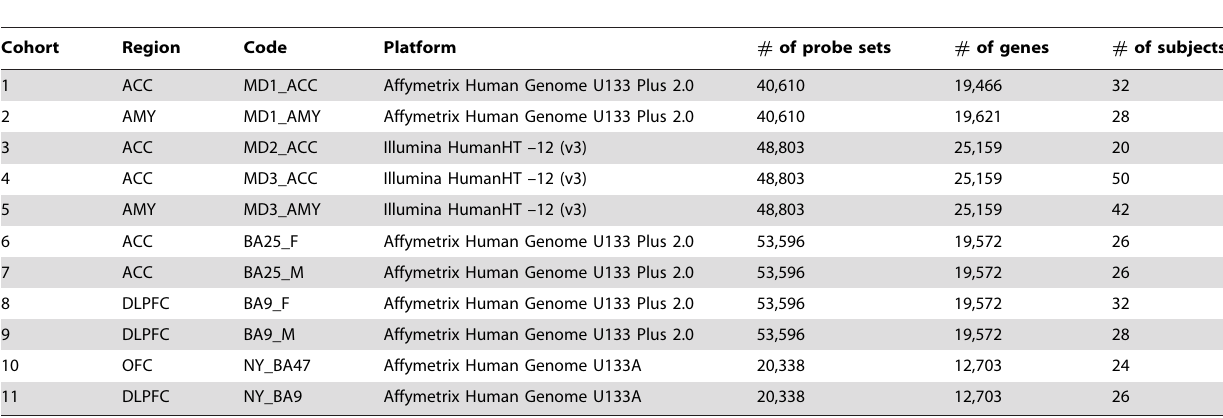
Table 1. Description of cohorts in 11 MDD microarray